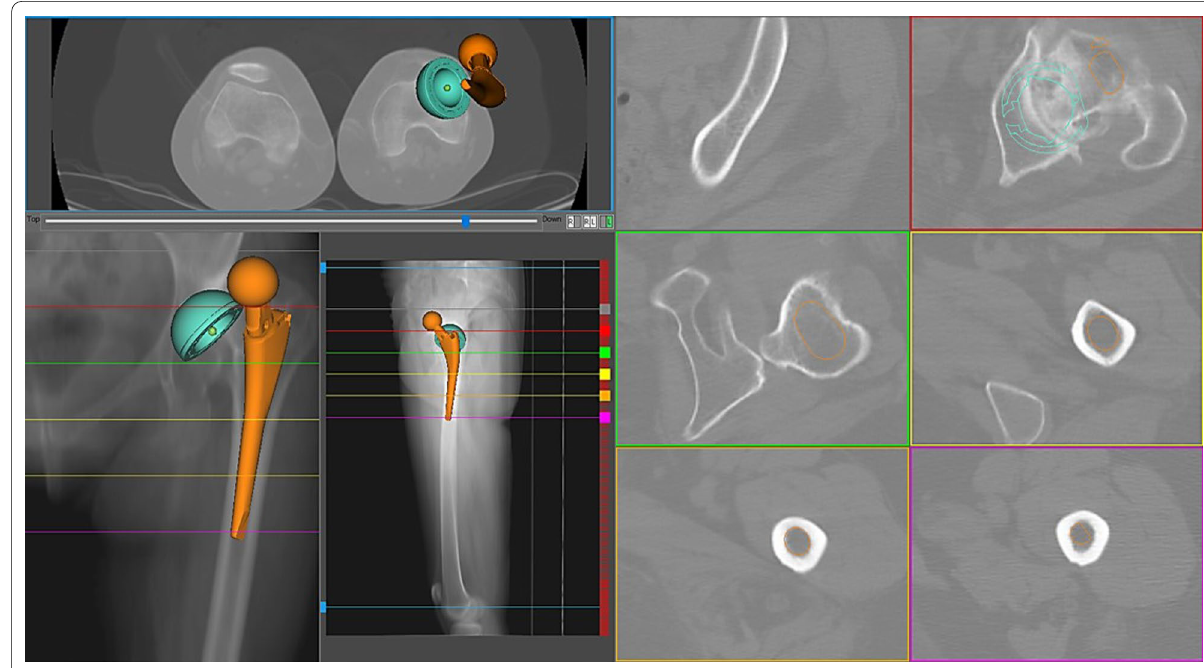
Fig. 3 An anatomical stem simulation was performed in the Crowe III dysplastic left hip of a 46-year-old female (native femoral anteversion 60°). Even with a cup anteversion of 16°, combined anteversion was beyond the limits (Dorr 70°, Widmer 54°), and the reconstruction was unacceptable